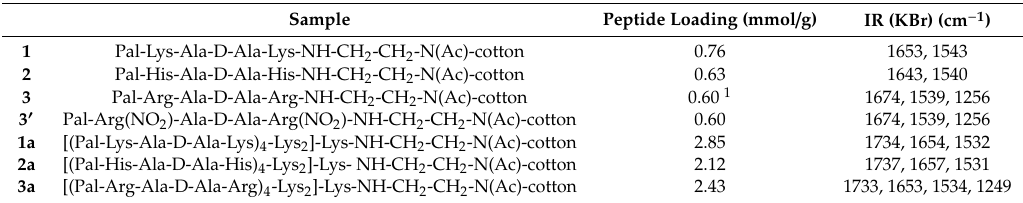
Table 1. Amino acid composition of the peptide-cotton samples, peptide loading values and relevant IR absorption signals.